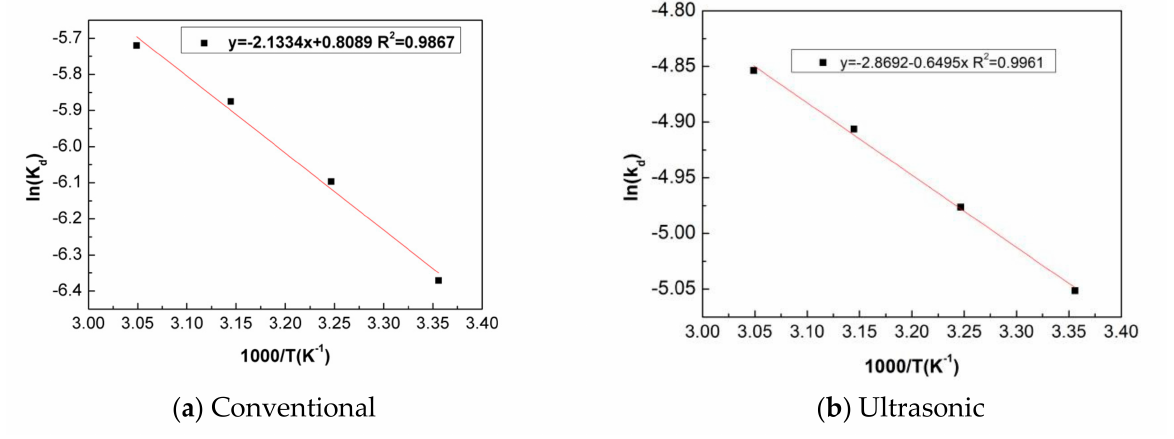
Figure 10. The relation between k d and T − 1 .